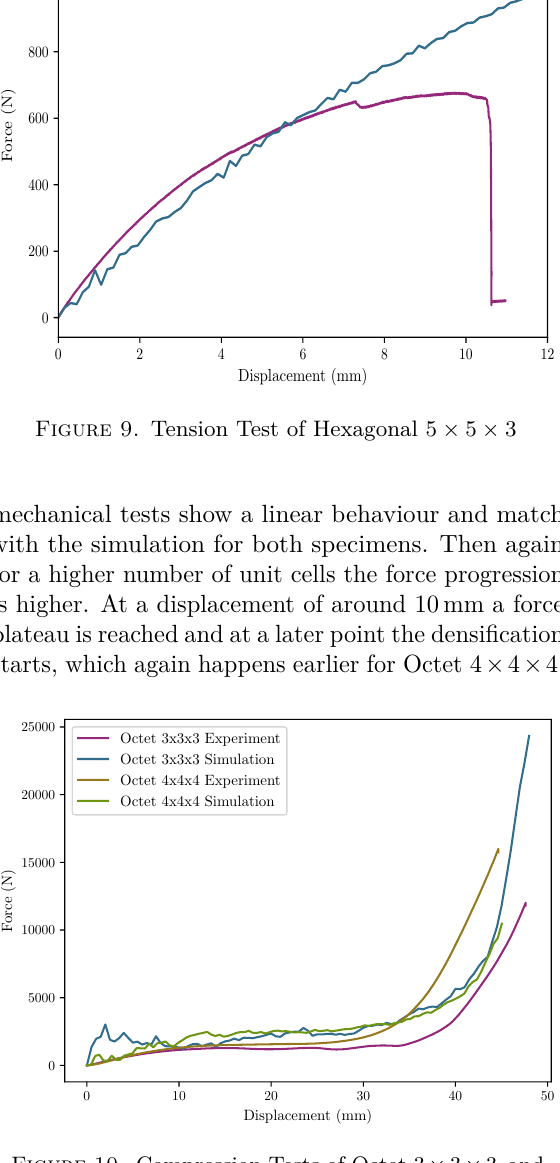
Figure 10. Compression Tests of Octet 3 × 3 × 3 and Octet 4 × 4 ×